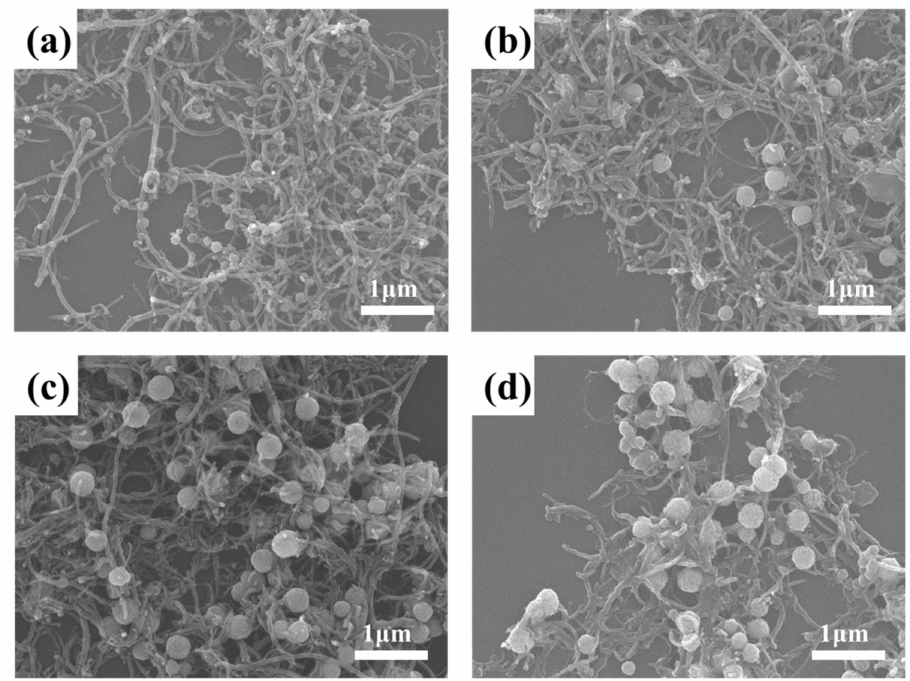
Figure 4. SEM images of Fe 3 O 4 /MWCNT composite with different size of clusters: ( a ) 100 nm, ( b ) 200 nm, ( c ) 300 nm and ( d ) 400